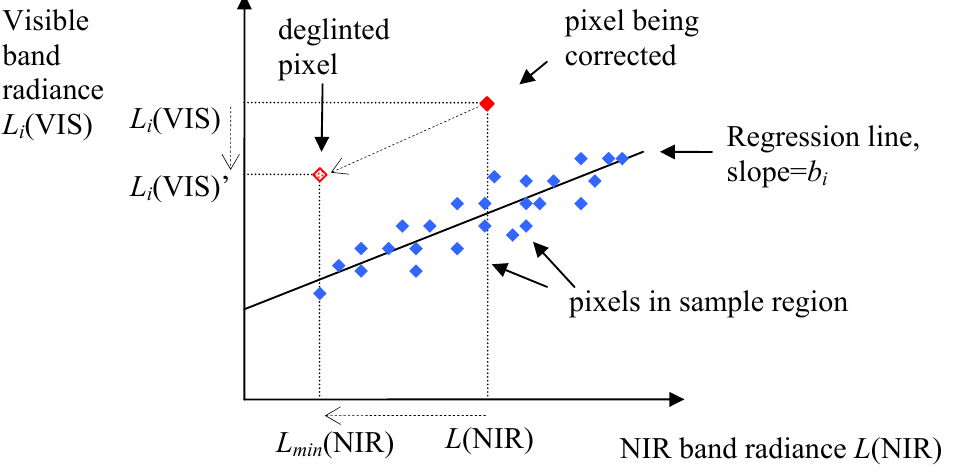
Figure 6. Graphical representation of the glint correction method of Hedley et al., based on their Figure 2 [10]. The pixel indicated by the red point is deglinted by reducing its NIR radiance to the minimum found in the sample region, and scaling the visible radiance using the regression